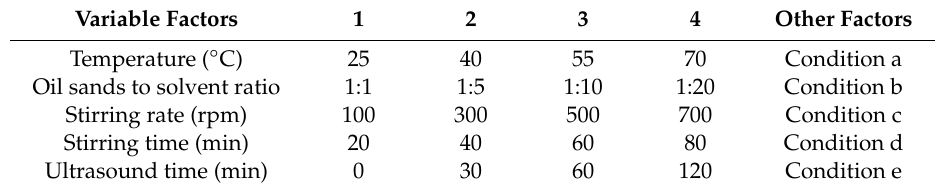
Table 1. The list of experimental conditions for the single factor experiment.